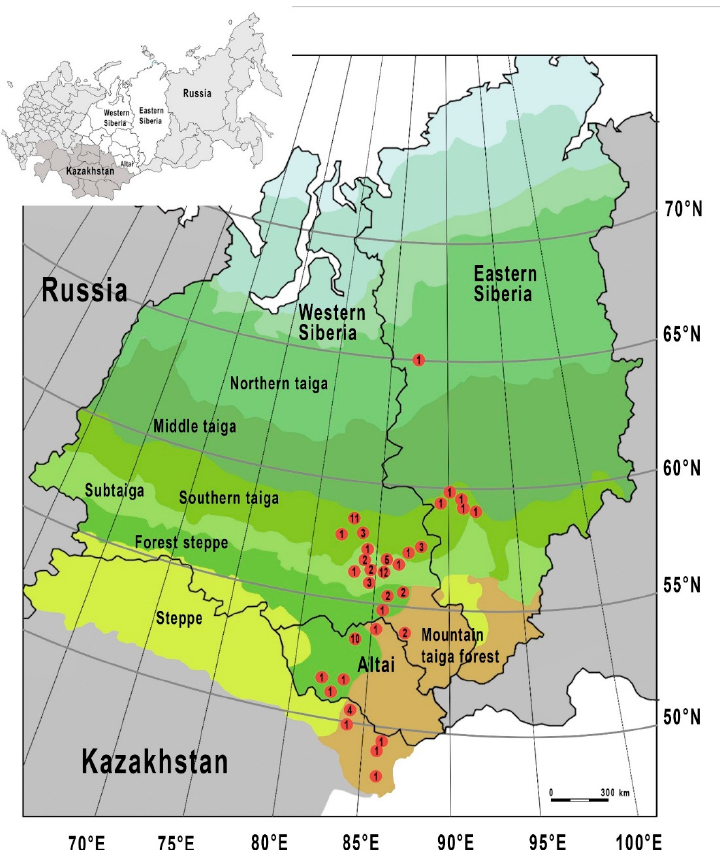
Figure 1. Distribution of monitored apiaries within the study ecoregions of North Asia (southern taiga, sub-taiga zone, forest steppe taiga, and mountain taiga forests). The number of the examined apiaries in the locality is indicated by numbers.